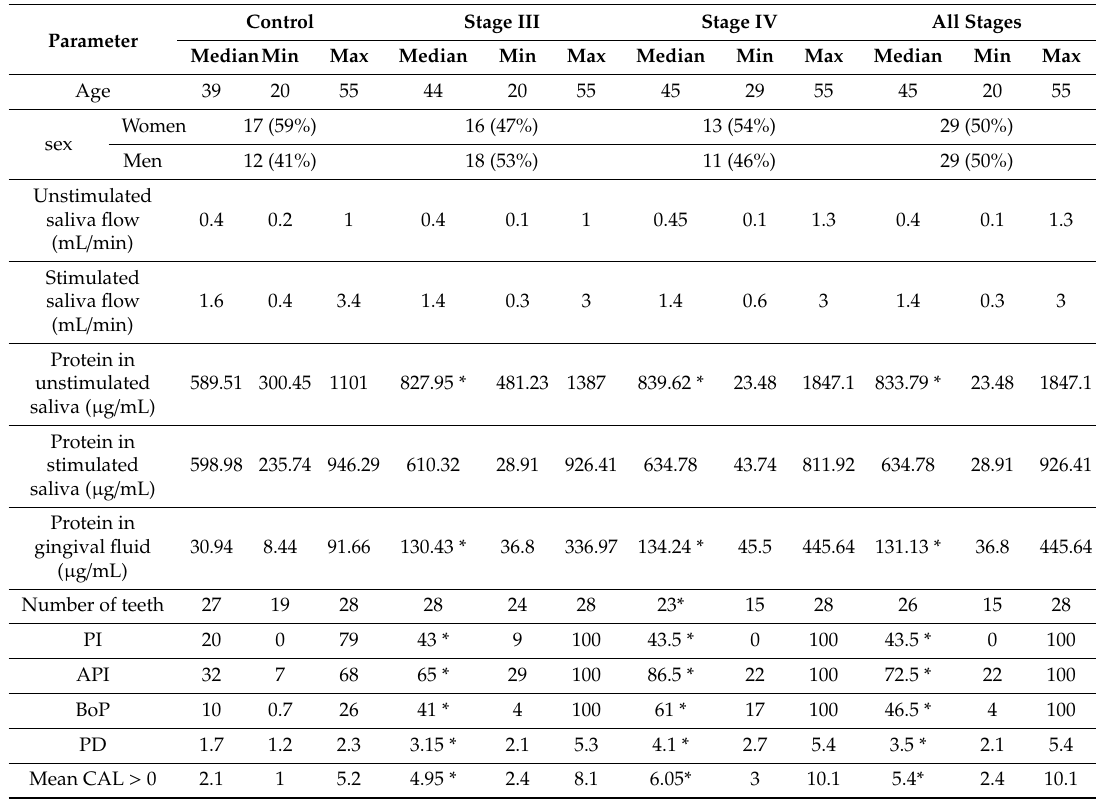
Table 1. General and periodontal data. API—approximal plaque index; BoP—bleeding on probing; CAL—clinical attachment level; PD—probing depth; PI—plaque